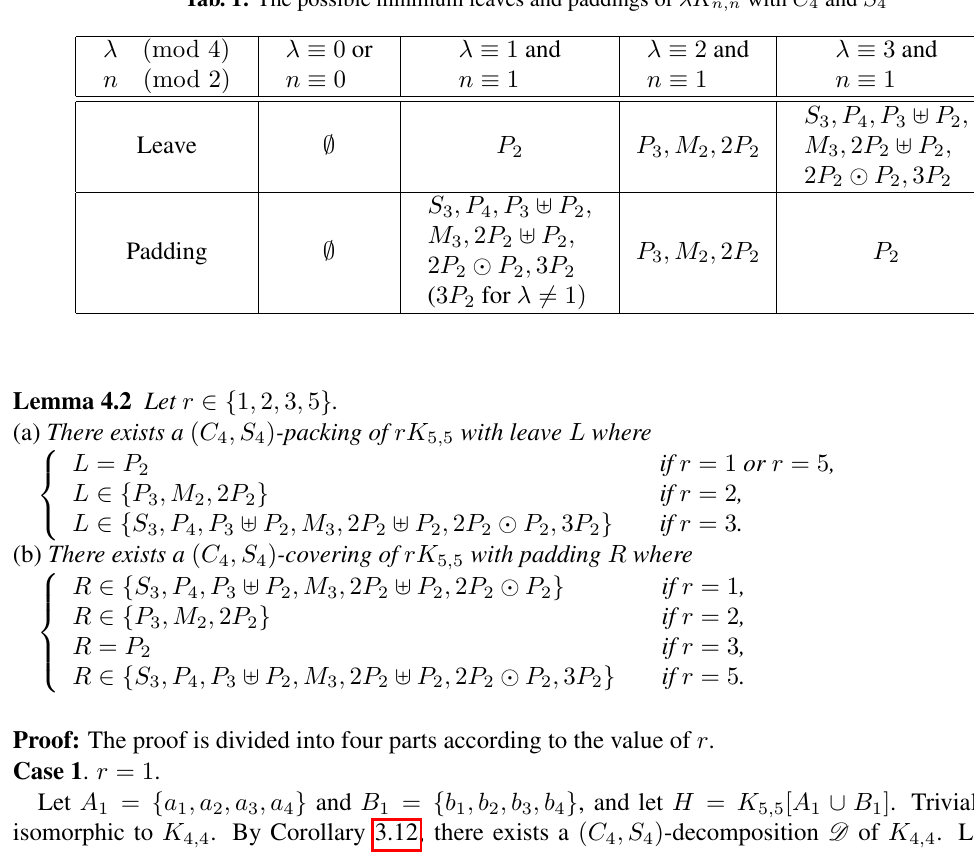
Tab. 1: The possible minimum leaves and paddings of λK n,n with C 4 and S